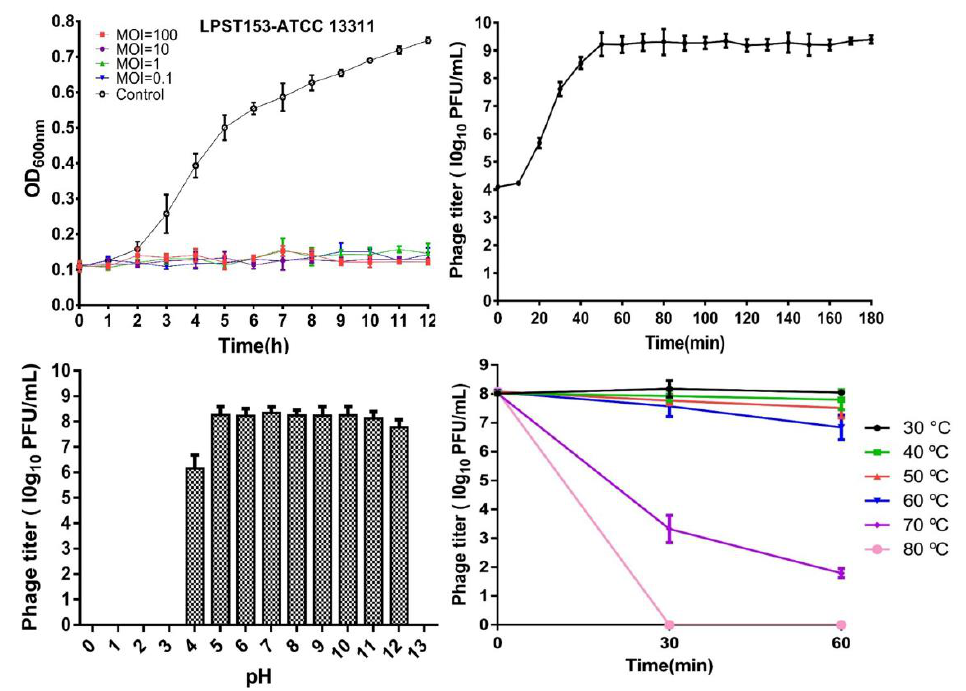
Figure 2. Characteristics of LPST153. ( A ) Lytic ability of phage LPST153 to lyse S. enterica serovar Typhimurium ATCC 13311 in TSB medium at different MOIs of 100, 10, 1 and 0.1 at 37 °C, ( B ) One step growth curve of LPST153, ( C ) pH stability, LPST153 exhibited pH stability range from 4 to 12, and ( D ) Temperature stability. LPST153 exhibited stable at 30 °C to 60 °C. Data were shown as mean with standard deviation of three determinations of each point.